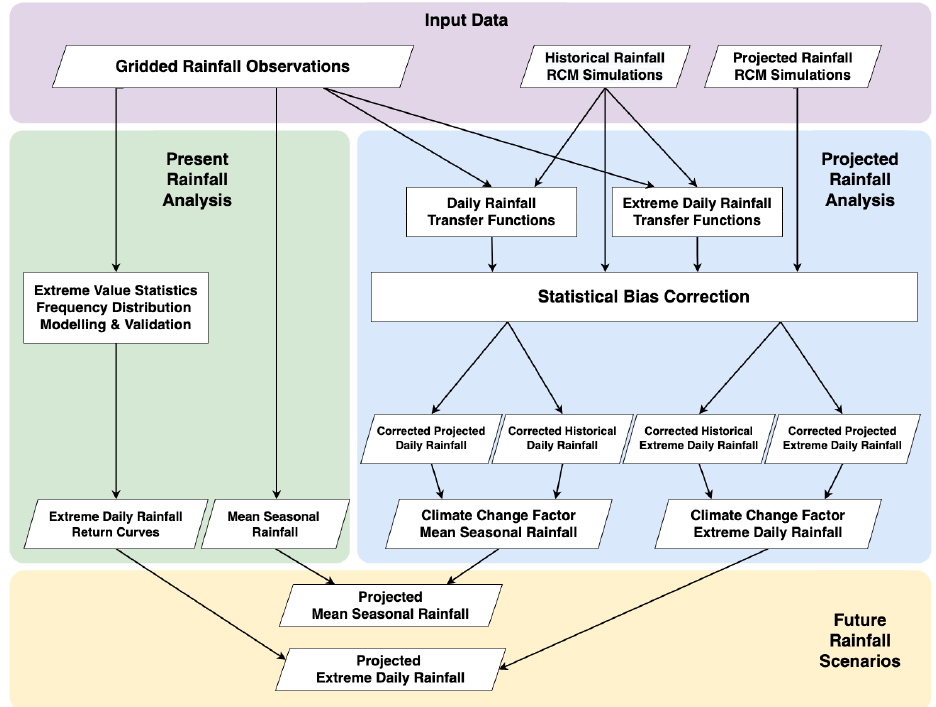
Figure 3. Methodological framework for the integration of analysis of present and future rainfall scenarios.